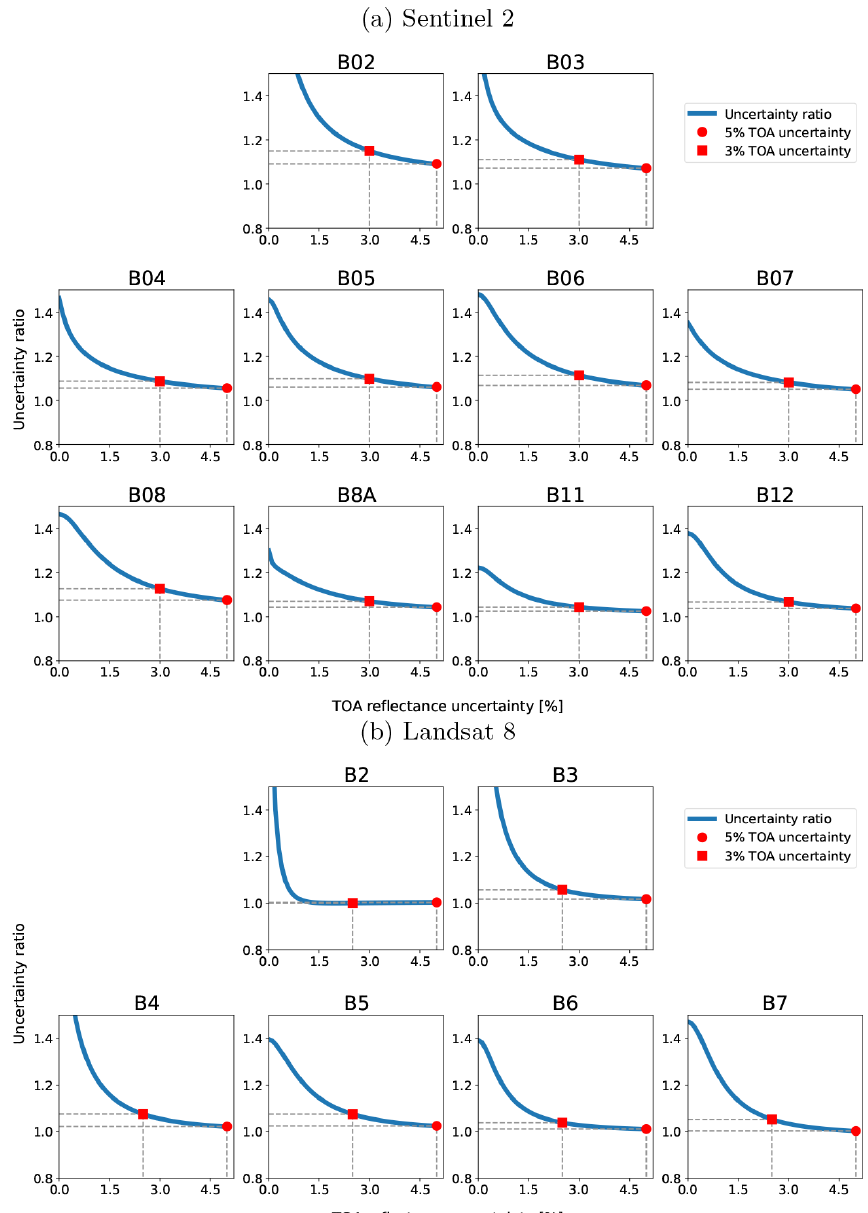
Figure I4. Surface reflectance uncertainty comparison between CAMS prior corrections and SIAC corrections. The ratio is calculated as CAMS prior-corrected surface reflectance uncertainty divided by SIAC surface reflectance uncertainty for different values of TOA uncer- tainty. The red dot indicates the uncertainty ratio when 5% of the TOA reflectance uncertainty is used, while the red square indicates the uncertainty ratio when 3% of the TOA reflectance is uncertainty